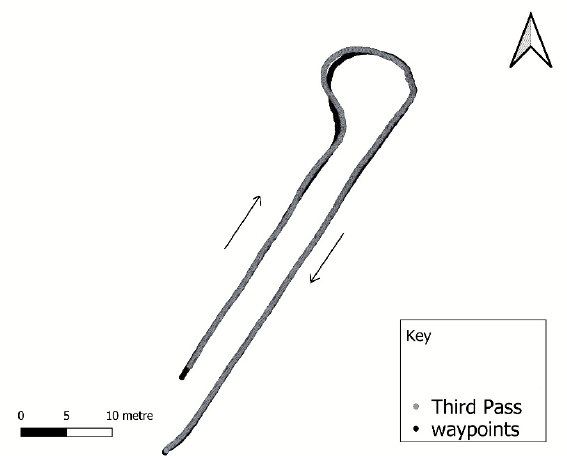
Figure 15. Path tracking of the prescribed path (black pass). The gray pass is the GPS generated path of the rover when following the rows using the prescribed path (black). The gray path trace is the third navigation pass experiment. The arrows show the passing direction of the rover.